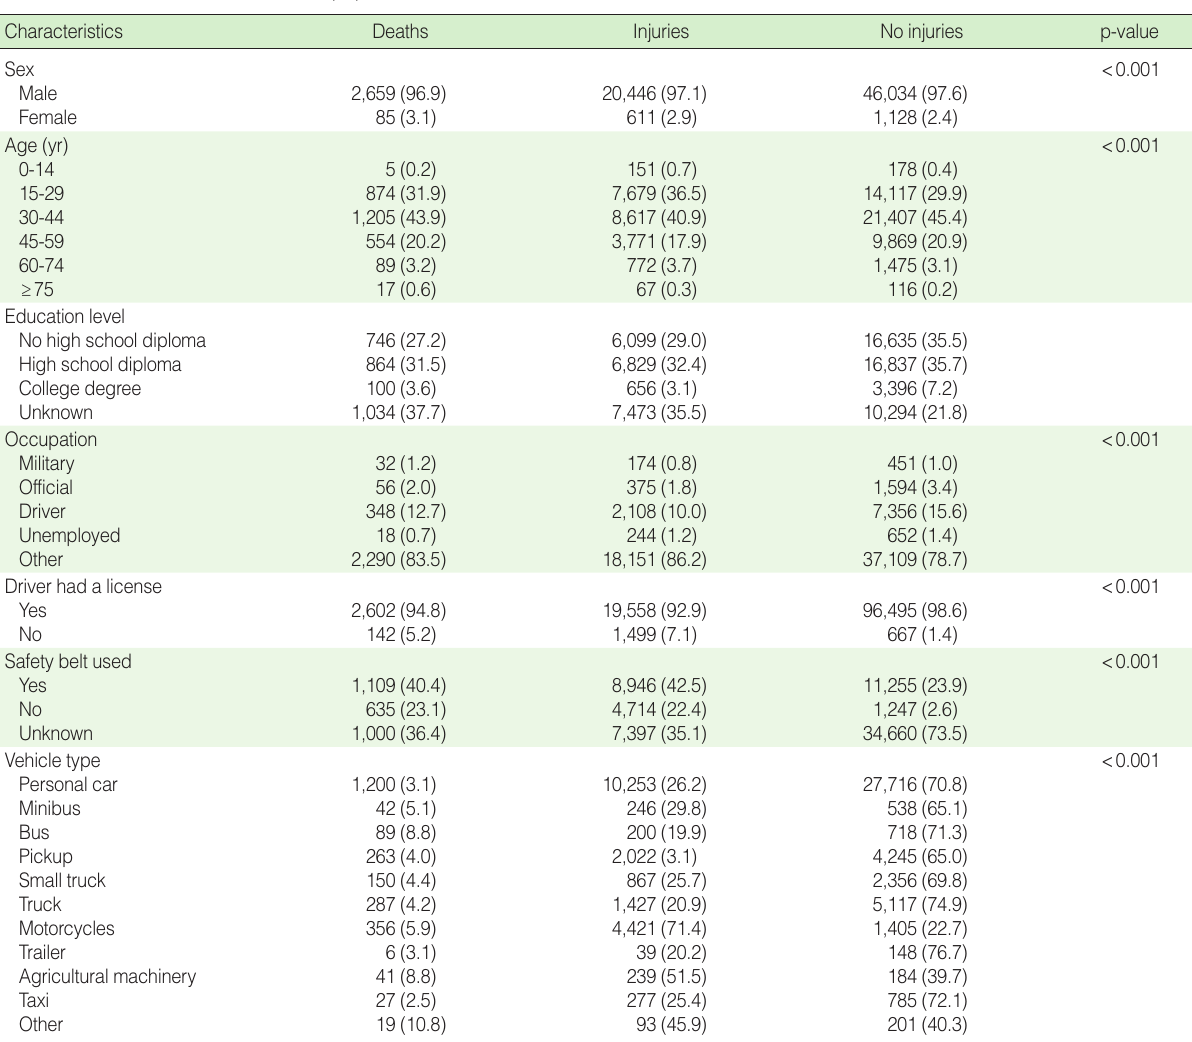
Table 1. General characteristics of the population studied